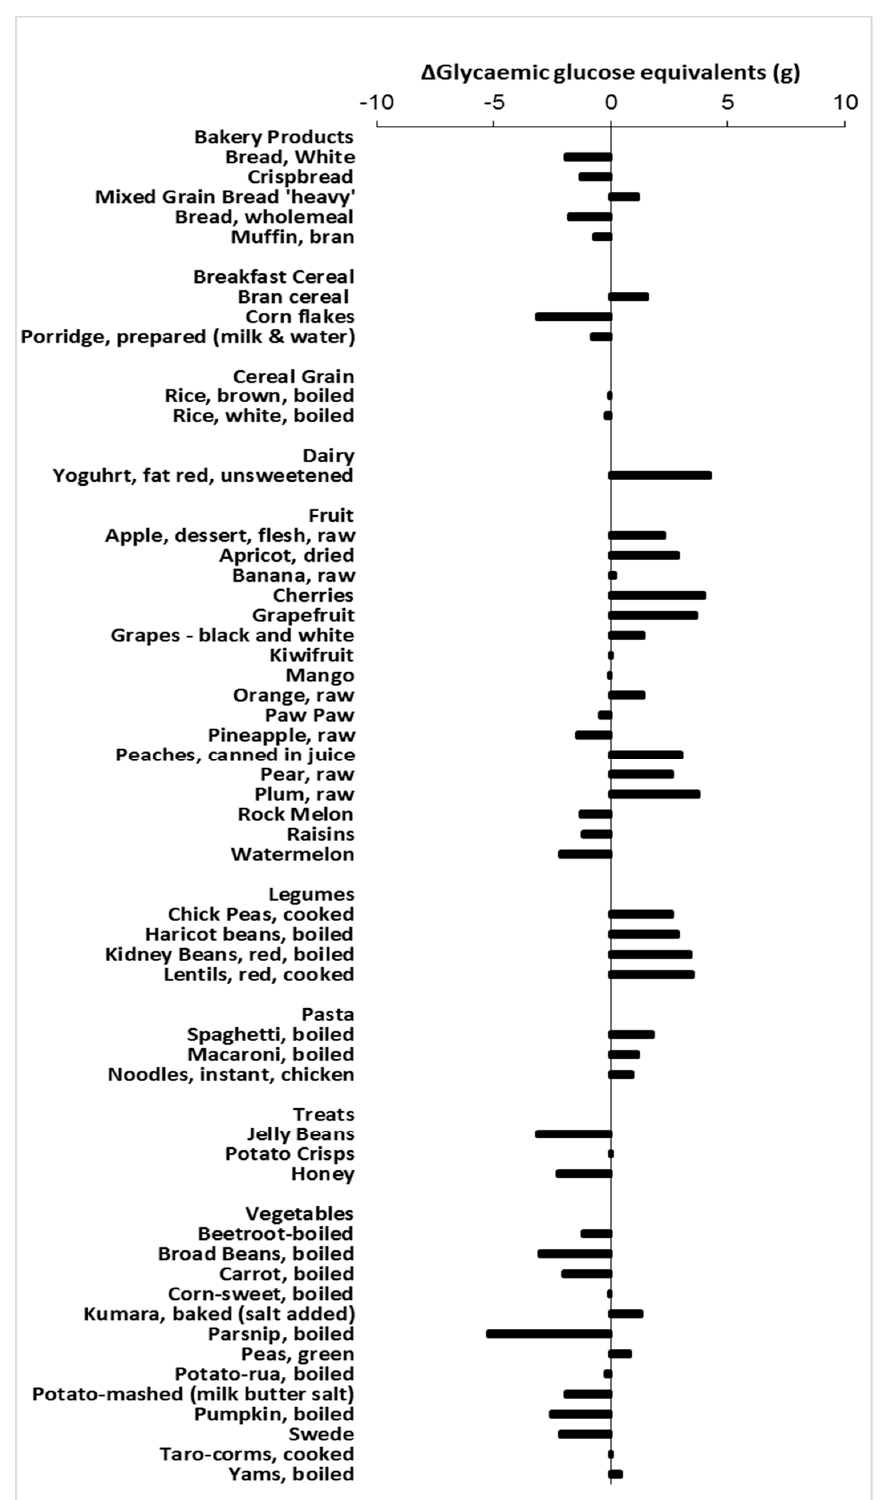
Figure 3. Change in glycaemic potential (GGE (g)) upon equi-carbohydrate substitution of one SunGold kiwifruit for various foods.